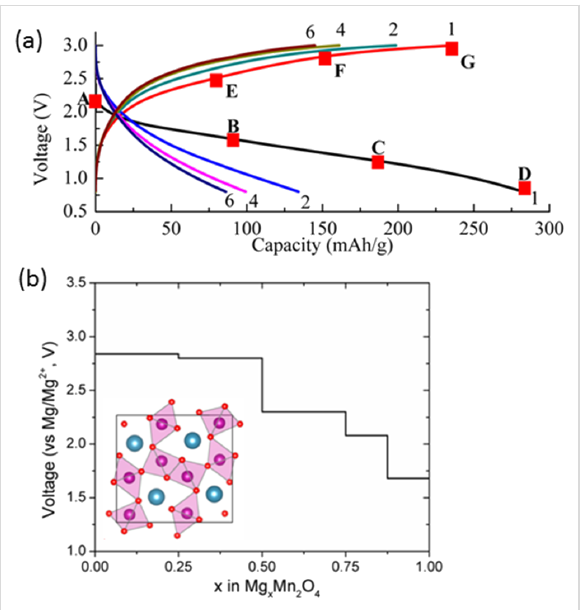
Figure 11: (a) Charge–discharge curves of α -MnO 2 in organohaloalu- minate/tetrahydrofuran electrolyte solution. Reprinted with permission from [81]. Copyright 2012 Elsevier. (b) Predicted voltage for electro- chemical insertion of Mg into the post spinel, MgMn 2 O 4 which was drawn in the inset. Adopted with permission from [82]. Copyright 2013 American Chemical